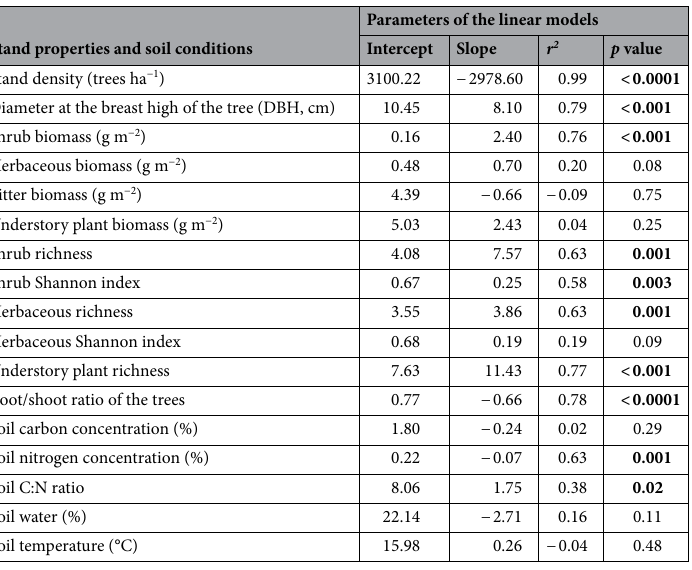
Table 2. Variation in stand characteristics, diversity and soil conditions along the thinning intensity. Parameters (intercept, slope, adjusted R -squared, and p- value) of the linear models were showed. P values in bold are significant at p <